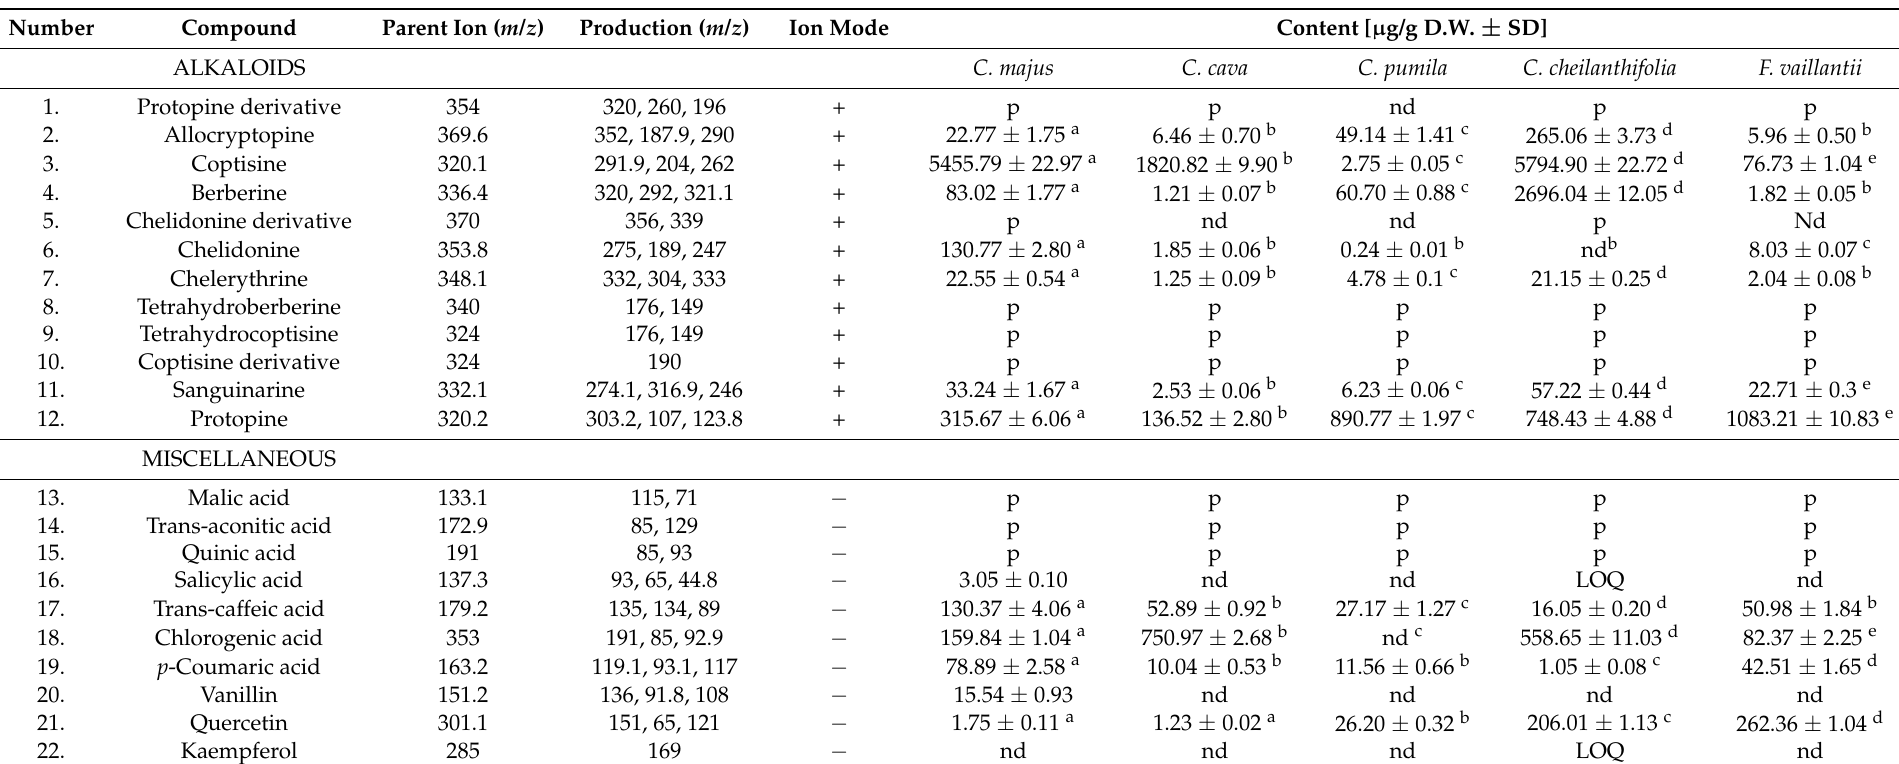
Table 1. Content [ µ g/g D.W. ± SD] of detected compounds in the aerial parts of C. majus , C. cava , C. pumila , C. cheilanthifolia , and F. vaillantii